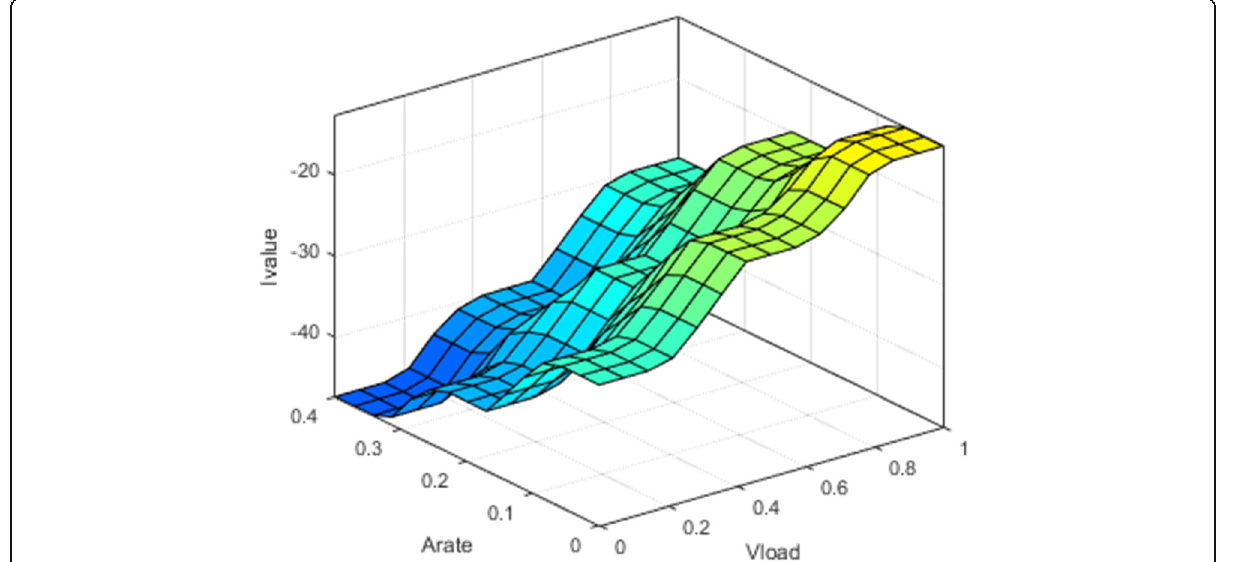
Fig. 9 Surface viewer of activation bias